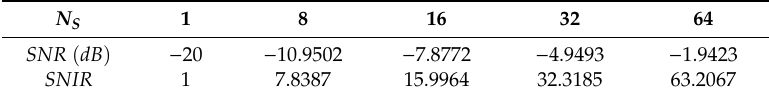
Table 2. The classical stacking method. The estimated parameters, SNR and SNIR are reported based on the synthetic noisy MRS signal with initial SNR = –20 dB. on the synthetic noisy MRS signal with U = − 20 dB.